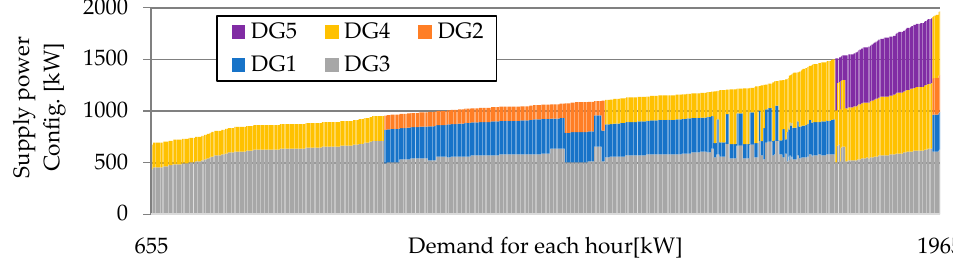
Figure 5. The load sharing pattern of the medium-speed DGs operated by the optimized load sharing method.